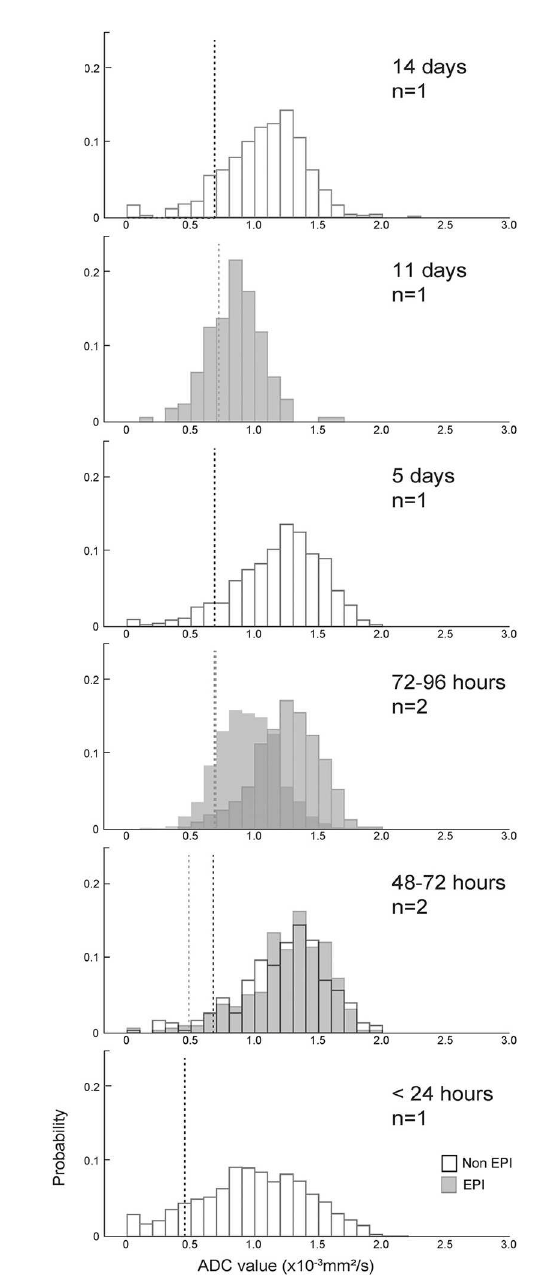
FIGURE6 ADC value histograms for the T2-FLAIR hyperintense region adjacent to eight hemorrhagic CVAs, arranged by duration of clinical signs (more recent events below older events). Black outline bars indicate non-EPI DWI, and gray bars indicate EPI DWI. The dotted lines show median ADC values for the control regions for each histogram, with black dotted lines corresponding to non-EPI DWI, and gray dotted lines corresponding to EPI DWI. Median absolute and relative ADC values for the T2-FLAIR ROIs, median absolute ADC values for the contralateral control regions, and anatomical locations of the lesions/control selections are listed in Table 1. There was no evidence of restricted diffusion adjacent to the T2* hypointense region in any dog.